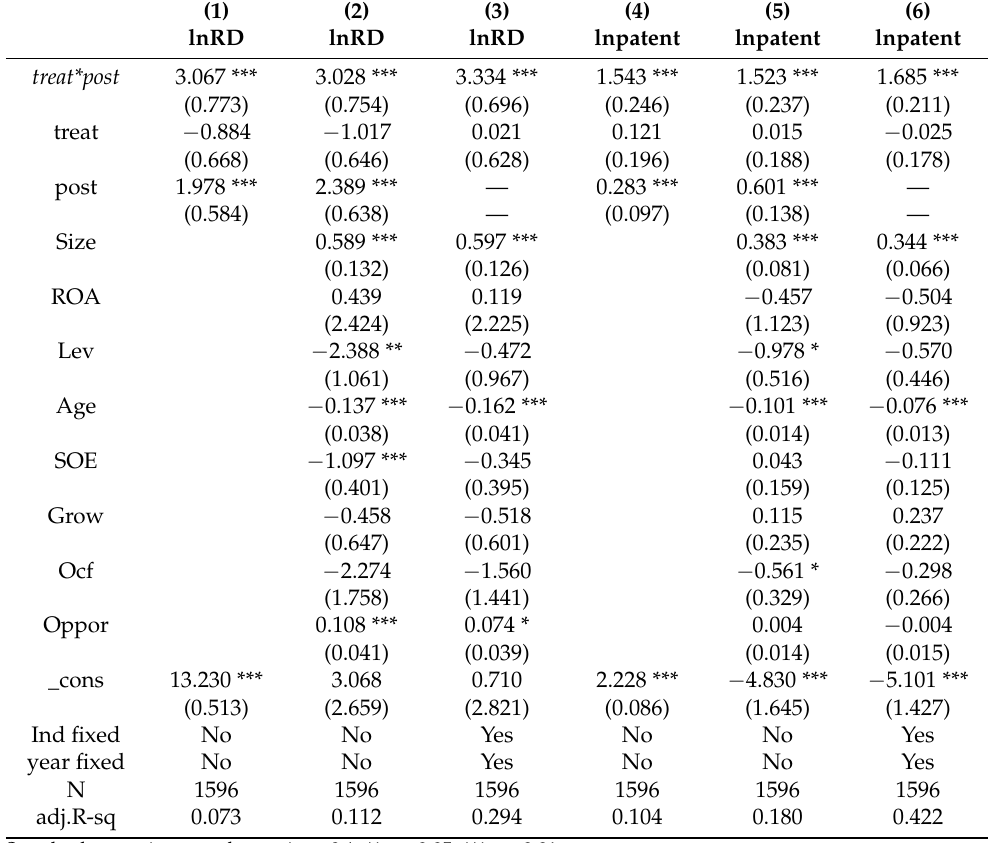
Table 8. The estimation results of the PSM-DID